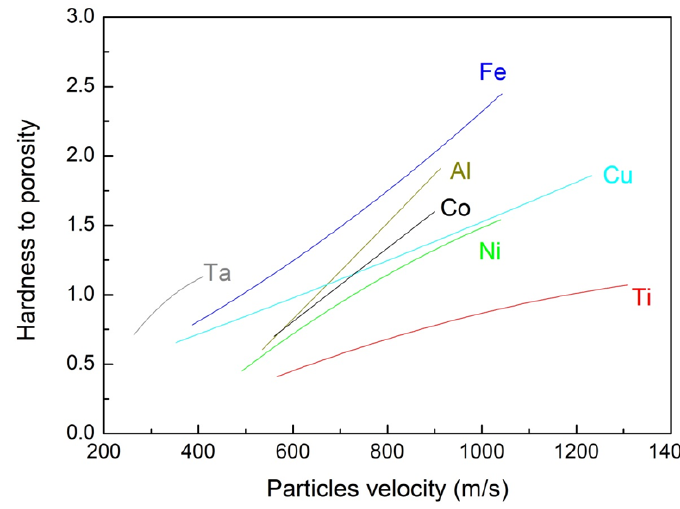
Figure 11. Particle velocity as a function of the hardness to porosity parameter.